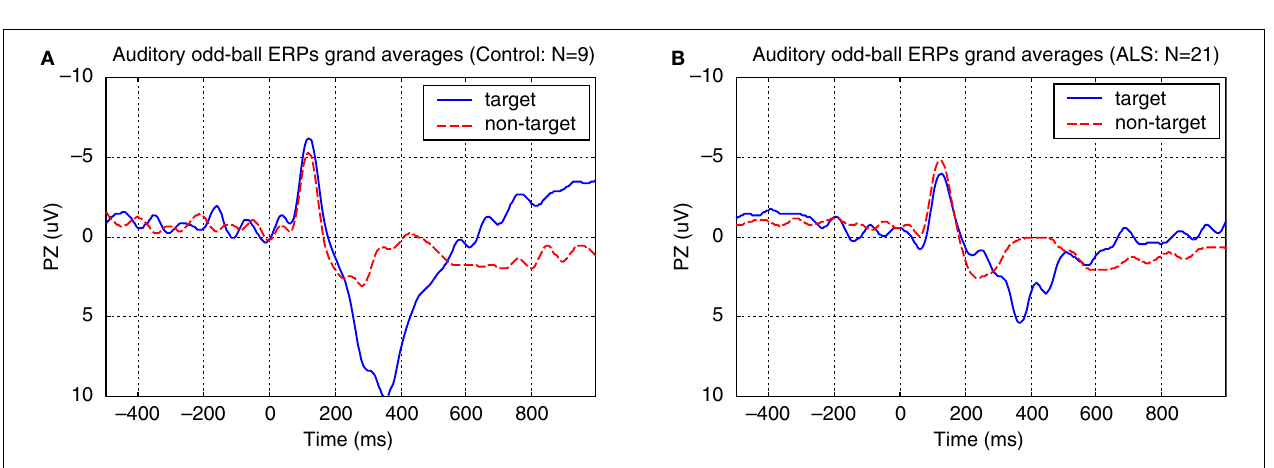
FIGURE 1 | Auditory odd-ball paradigm ERPs grand averages. (A) Control, (B) ALS. Mean ± SD number of target stimuli: 34 ± 9 (non-target stimuli: 168 ± 23). The auditory odd-ball paradigm was administered to each participant before the BCI training.